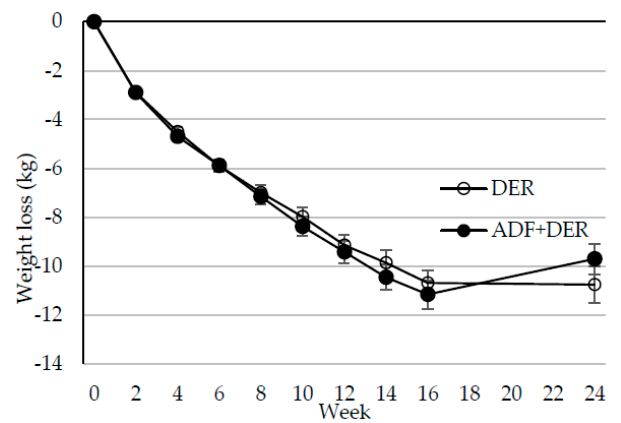
Figure 2. Mean ± standard error change in bodyweight after 16 weeks of the DER ( n = 68) or ADF + DER diet ( n = 67), followed by eight weeks of weight maintenance. DER, standard meal replacement program; ADF + DER modified meal replacement program. For between group differences, p > 0.05; for time effect p < 0.01; for group differences over time (time × diet interaction) p > 0.05, using linear mixed-effects model analysis. Table 3. Anthropometric and metabolic measurements in the DER and ADF + DER groups before and after the 16-week energy restriction intervention 1 .